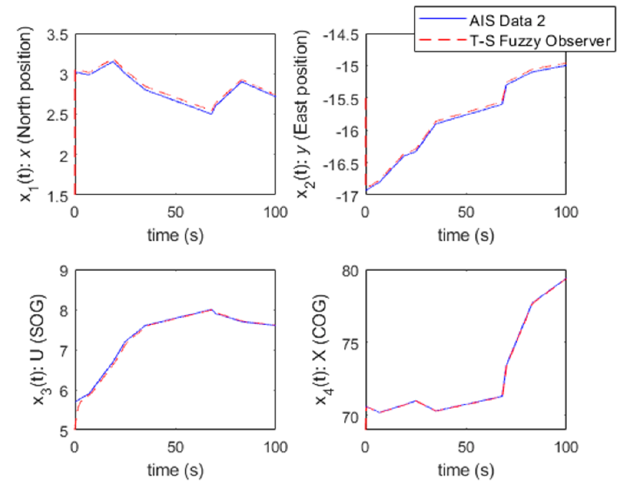
Figure 11. Simulation results of AIS data 2.